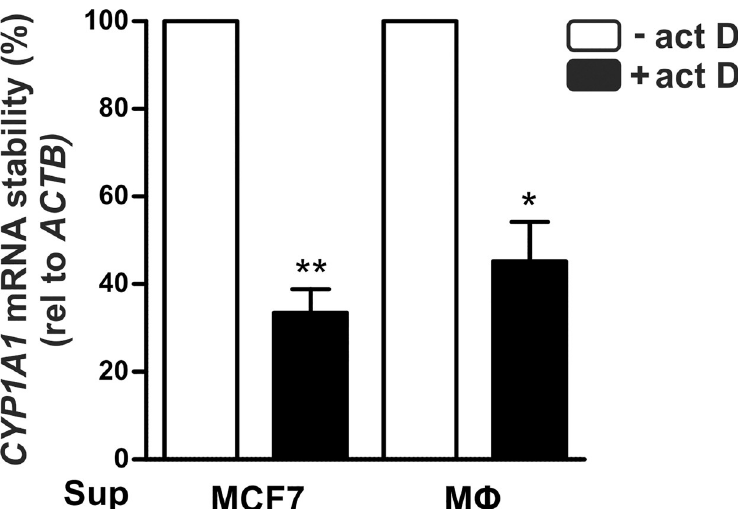
Fig 4. CYP1A1 mRNA stability. MCF7 cells were incubated with supernatants of MCF7 cells or M F s for 48 hours. De novo mRNA synthesis was blocked by addition of the transcription inhibitor actinomycin D (act D, 4 μ g/ml) for the last 2 hours. CYP1A1 mRNA expression was determined by RT-qPCR analysis and normalized to ACTB . mRNA stability is given as mean expression ± SEM after 2 h act D relative to cells incubated with the respective supernatants without addition of act D (n = 3, � p < 0.05, �� p < 0.01).